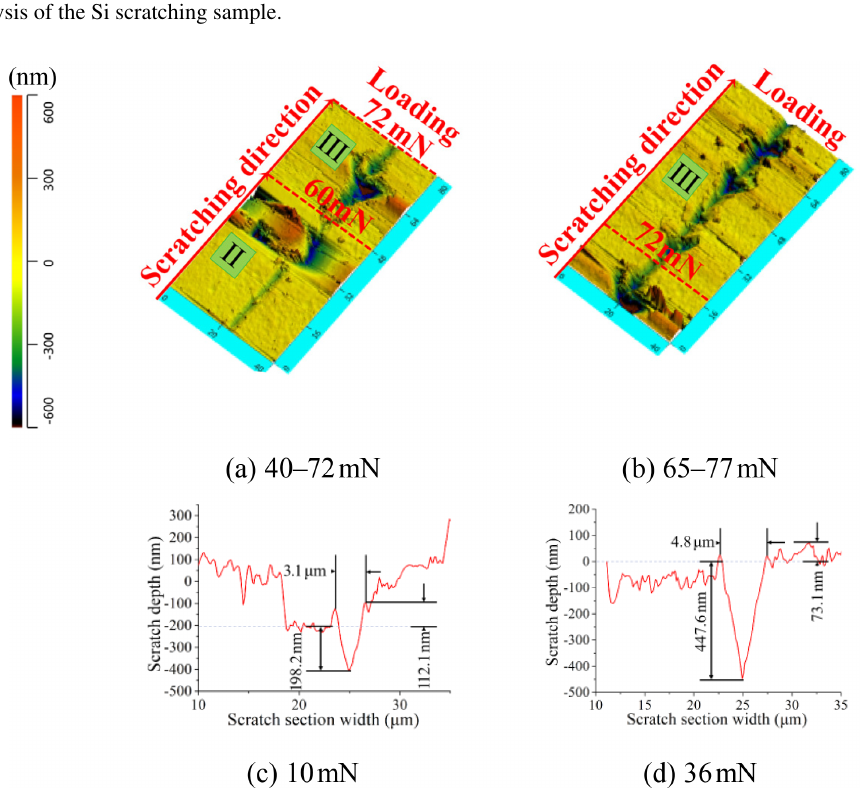
Figure 8. AFM analysis of the Si (UV-2 # ) scratching sample.